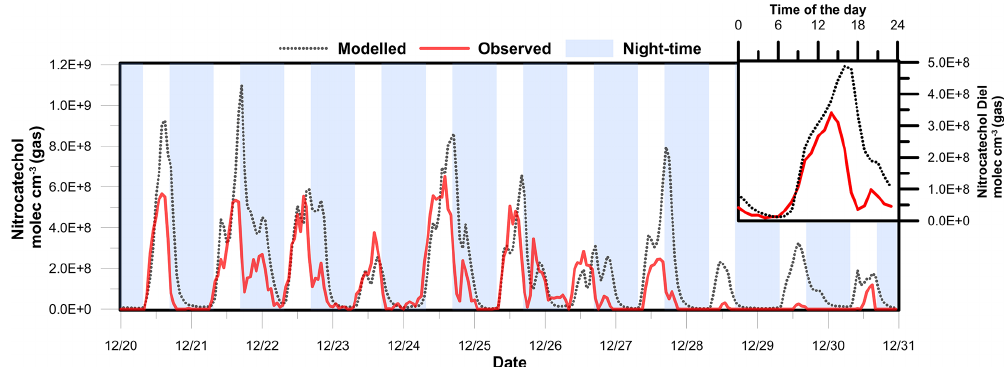
Figure 8. Modelled and observed nitrocatechol concentration time series. The inset shows the diurnal profile of the observed and modelled nitrocatechol